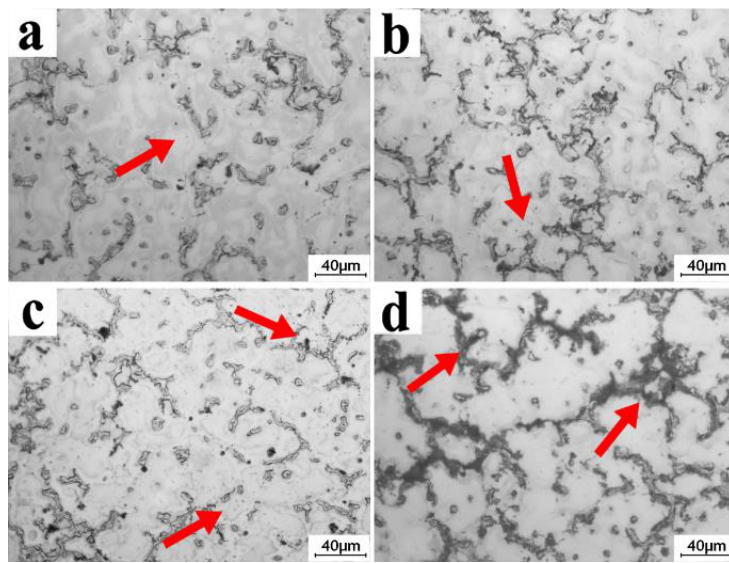
Figure 8. The location of Grp in the Grp/AZ91D composites with different Grp contents: ( a ) 0.5 wt.%, ( b ) 1.5wt.%, ( c ) 2.0wt.%, and ( d ) 2.5wt.%. (Red arrows: the particles of Grp).